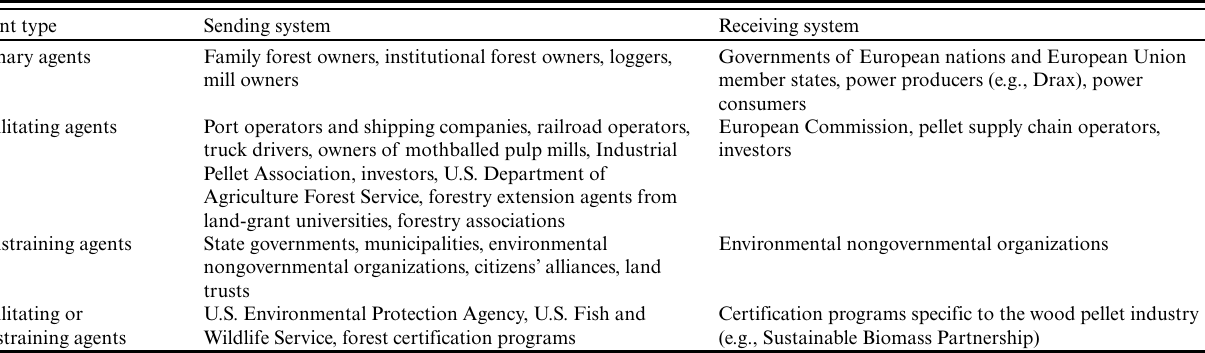
Table 4. Agents within the telecoupled transatlantic wood pellet trade system. Primary agents are the system’s key decision makers, facilitating agents tend to increase flows within the system, and constraining agents tend to decrease flows within the